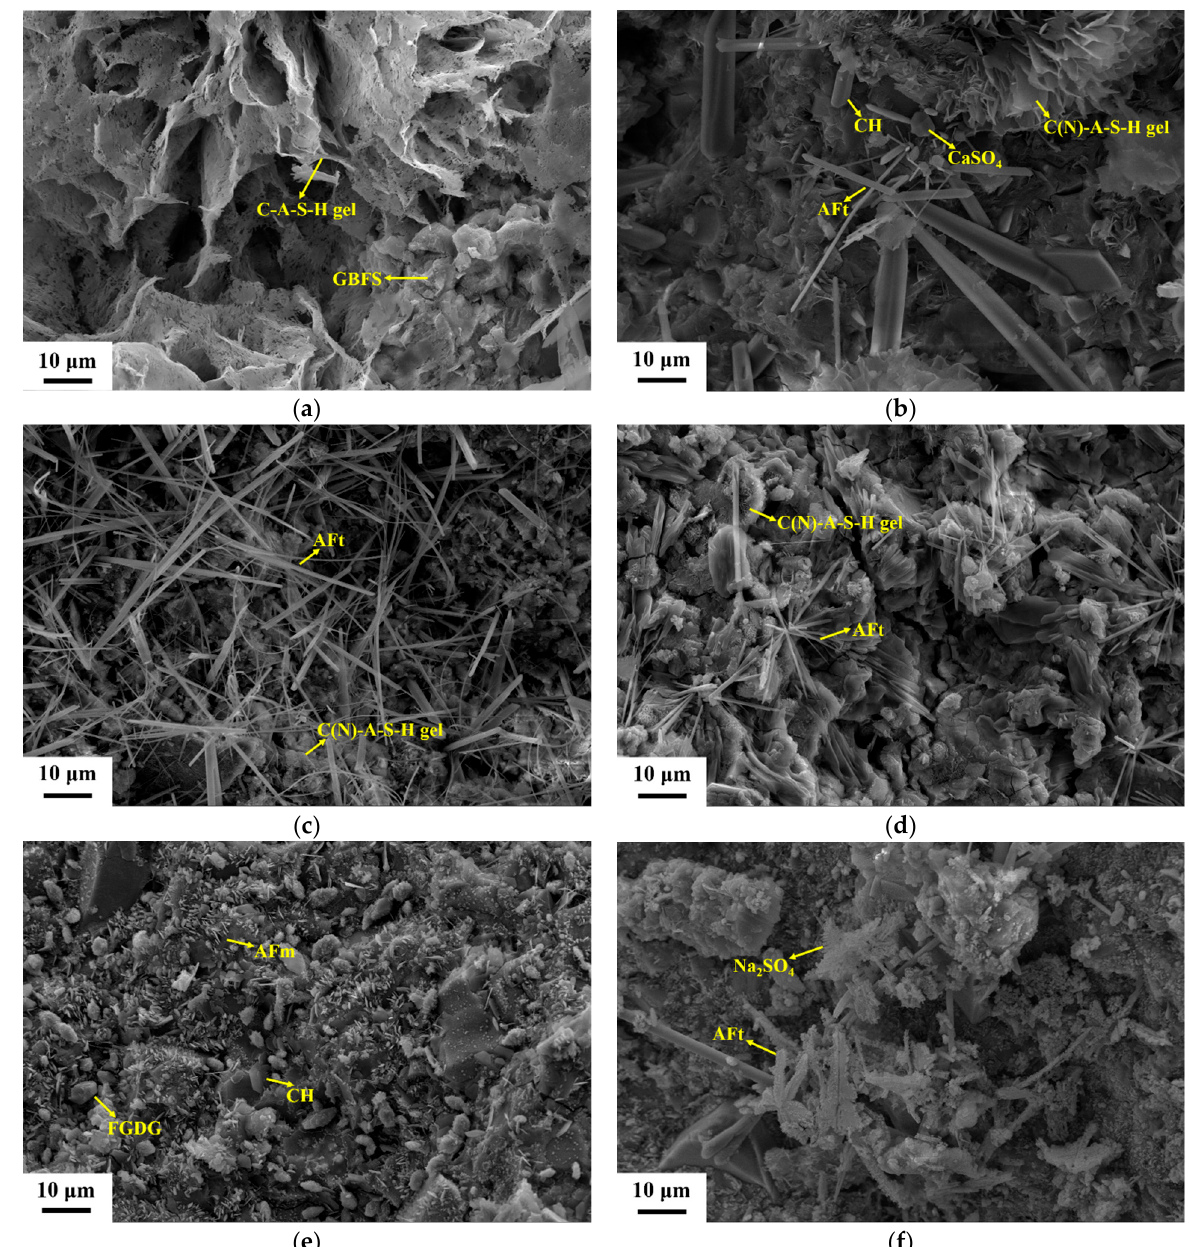
Figure 13. SEM test of the cement paste at 3 days: ( a ) S; ( b ) FG-5; ( c ) FG-25; ( d ) FGDG-3; ( e ) FGDG-6; ( f ) FGDG-12.